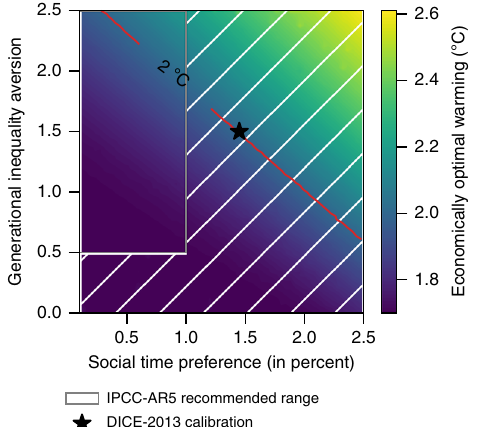
Fig. 5 Sensitivity of the economically optimal temperature in 2100 to alternative initial rates of social time preference and generational inequality aversion. These simulations are based on the benchmark impact estimate as in Fig. 2 with an equilibrium climate sensitivity (ECS) of 2.9 °C. The unhatched box indicates the range of values recommended by the IPCC-AR5 report 29 . The black star depicts the DICE-2013 16 calibration. The red line marks the 2 °C